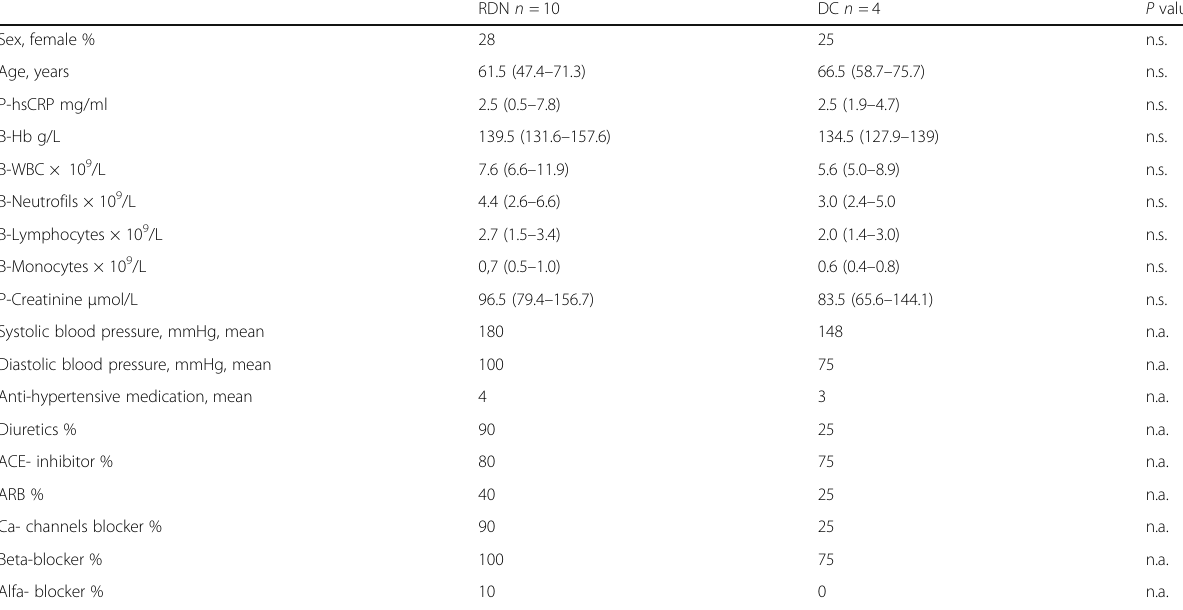
Table 1 Clinical and biochemical characteristics of RDN patients and DC